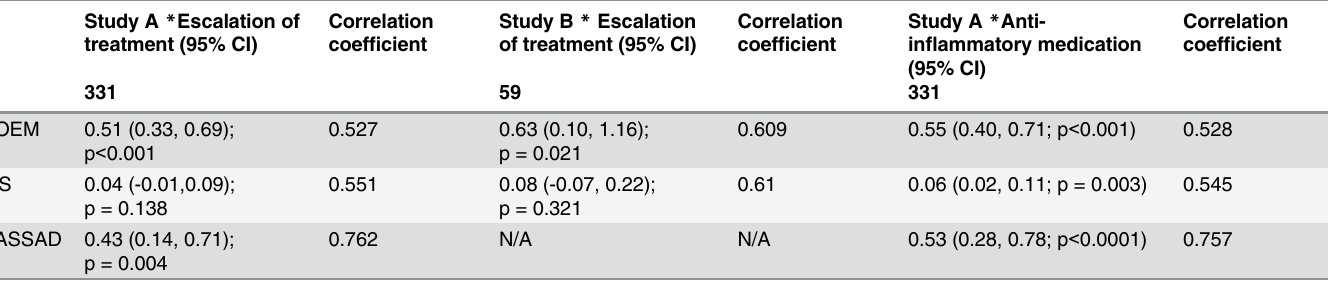
Table 5. Mean increase in AE severity scales per unit increase in number of days when treatment escalated and use of a topical